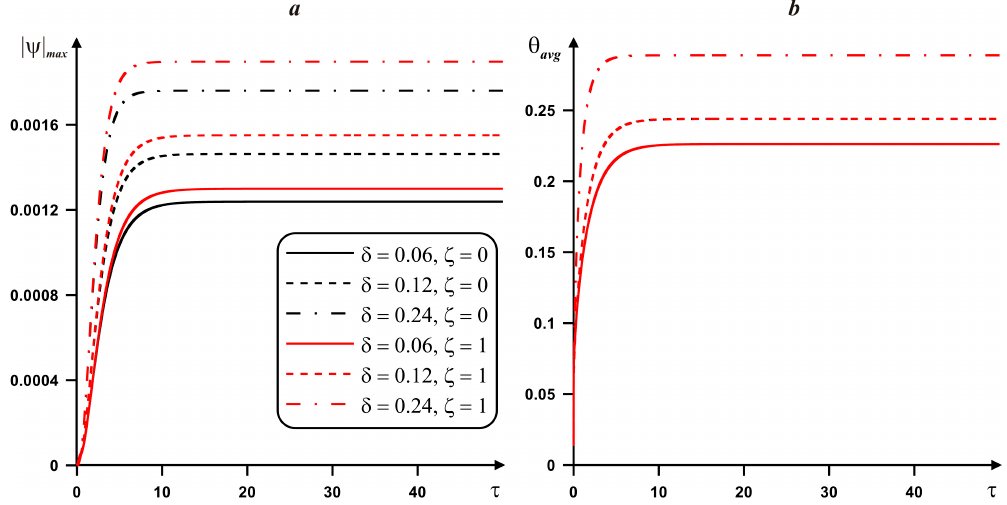
Figure 4. Isolines of ψ and θ for h 1 = 0.15, ζ = 0 (solid lines), ζ = 1 (dashed lines): ( a ) δ = 0.06; ( b ) δ = 0.12; ( c ) δ = 0.24.